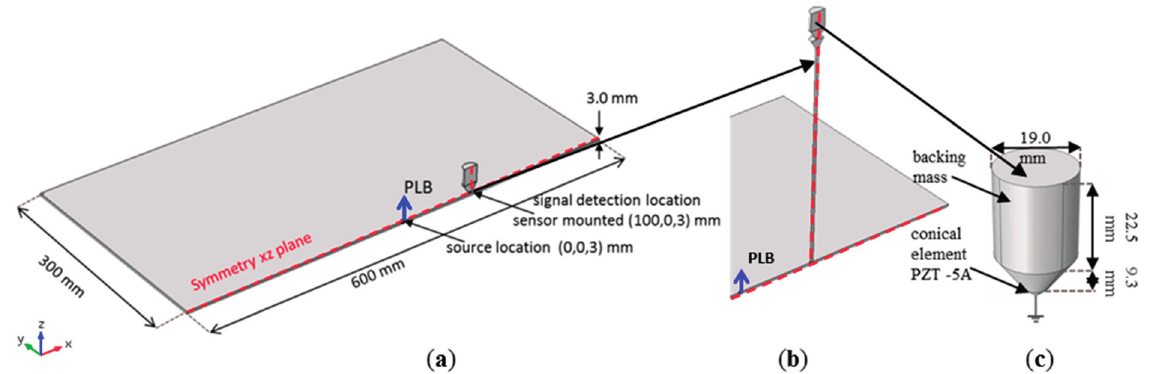
Figure 3. Geometry model for the ( a ) plate and sensor ( b ) plate, WG and sensor and ( c ) details of the conical sensor used